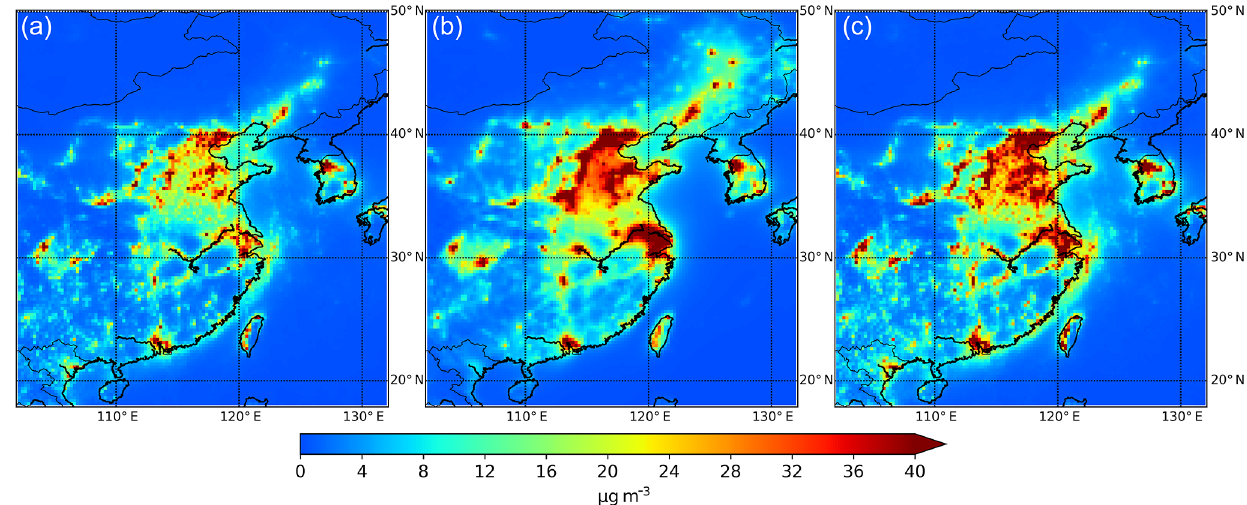
Figure 2. Annual mean surface NO 2 concentration in 2015 based on the CHIMERE model driven by the DECSO inventory, 2015 (a) ; the MIX Asian inventory, 2010 (b) ; and the corrected DECSO inventory (c) .